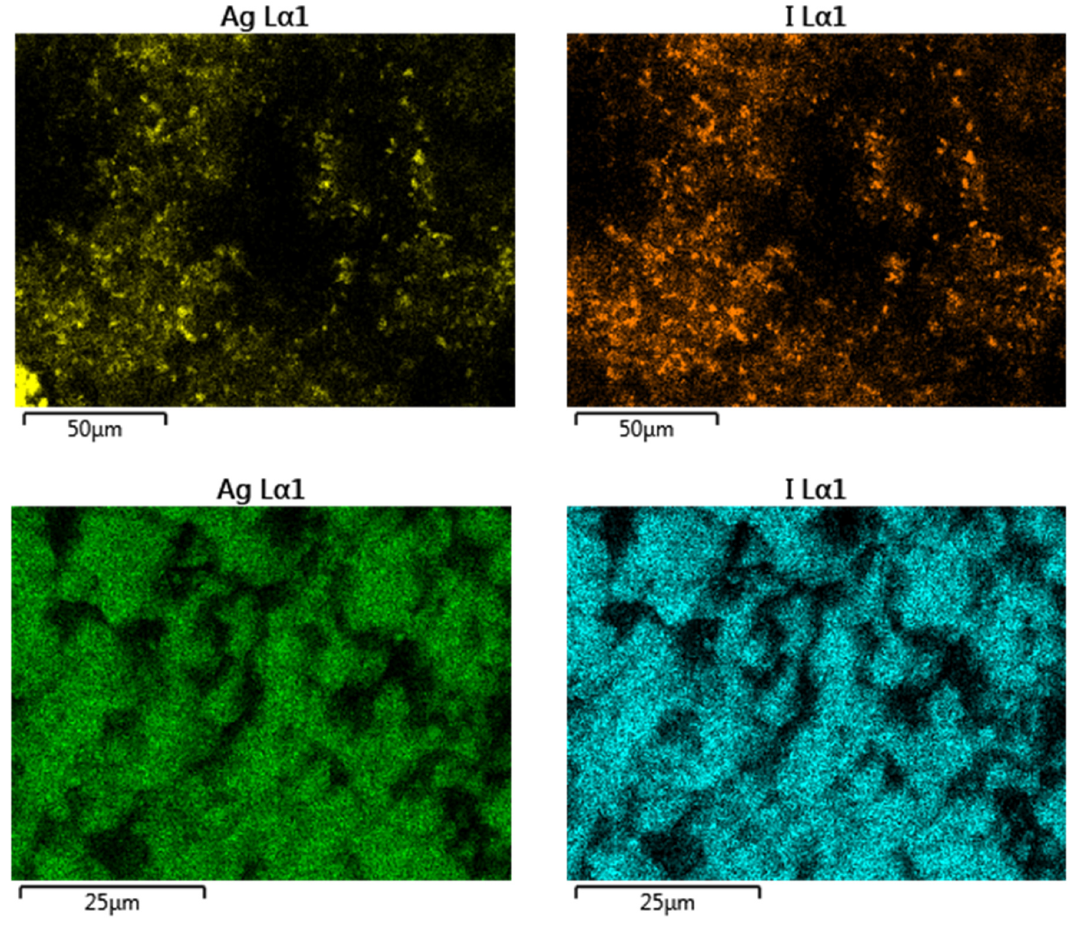
Figure 8. SEM/EDS mapping images of Ag 2 O@NZU ( upper ) and Ag 0 @NZU ( lower ) samples. TEM analysis performed on the samples after iodide adsorption from the 200 ppm solution showed less nanoparticles and dark areas as a result of the surface coverage with the precipitate (Figure 9). TEM / EDS analysis of individual Ag nanoparticles after the iodide adsorption showed very low iodide content, confirming the AgI decomposition under high-energy electron